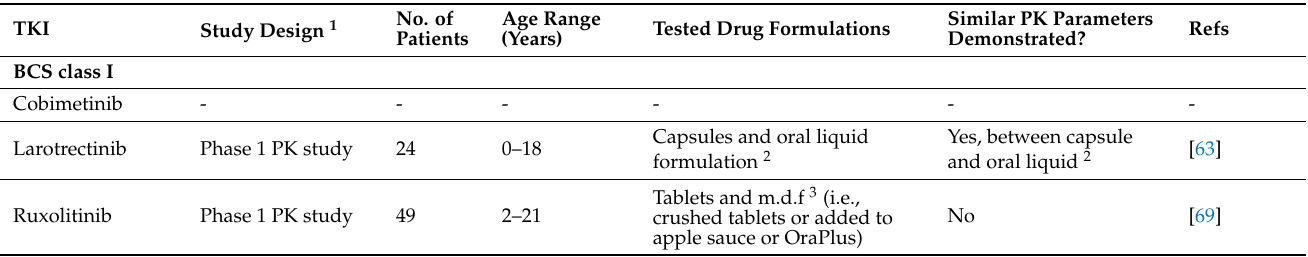
Table A2. Summary PK studies performed in pediatric oncology